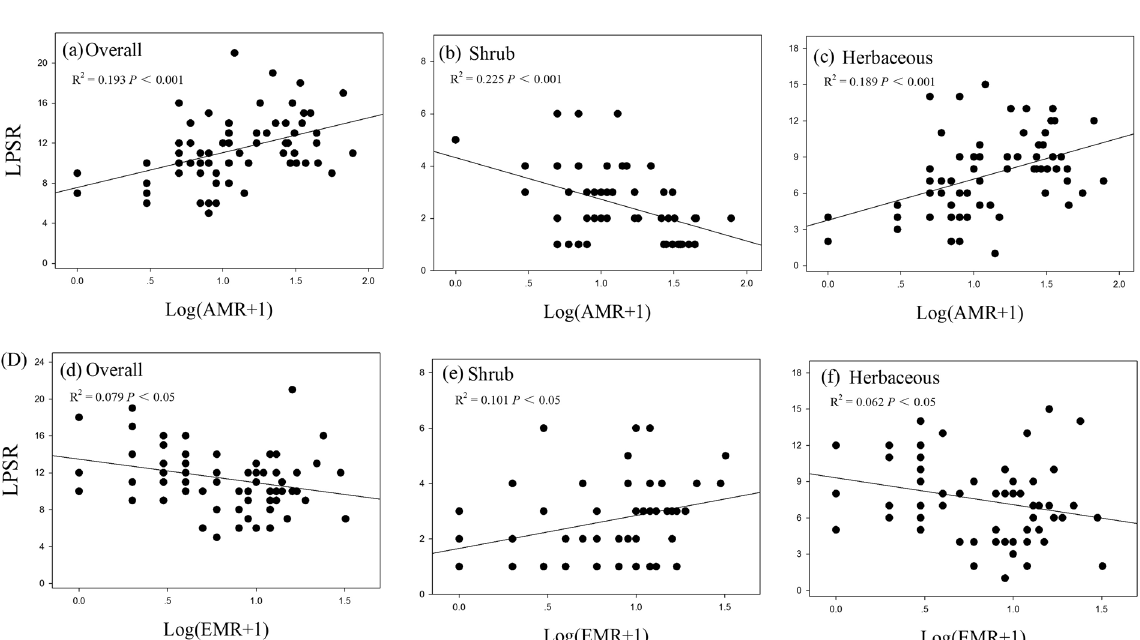
Figure 4. Relationships between overall, shrub, and herbaceous LPSR and soil arbuscular mycorrhizal ( a – c ) and ectomycorrhizal richness ( d – f ). Log(AMR + 1), Log (arbuscular mycorrhizal richness + 1); Log(EMR + 1), Log(ectomycorrhizal richness +